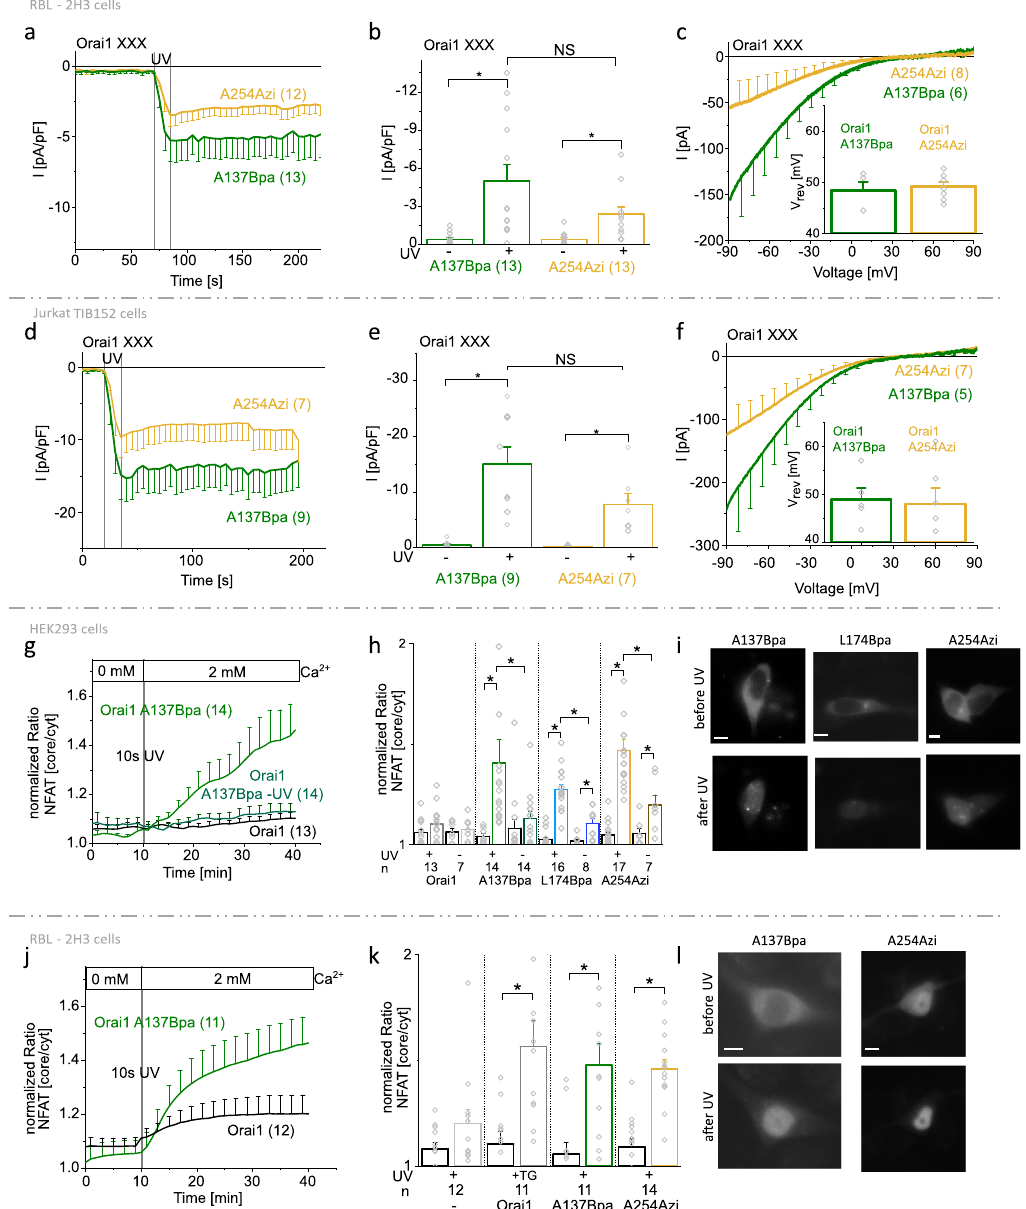
Fig. 9 | Photocrosslinking of light-sensitive Orai1 mutants trigger Ca